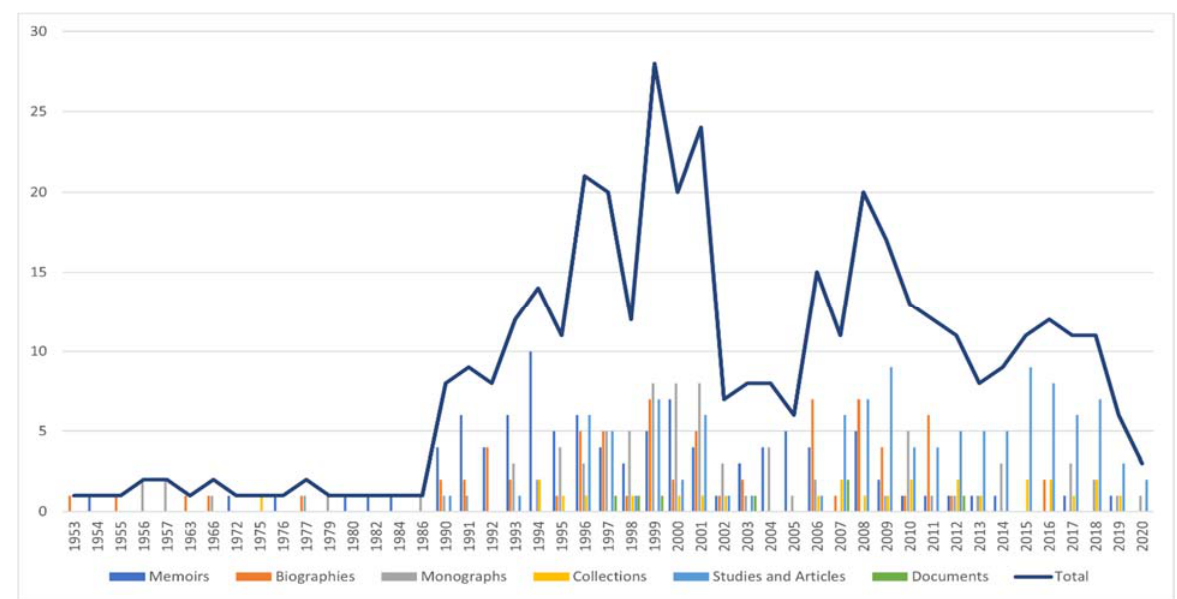
Figure 1. Timeline of publications.